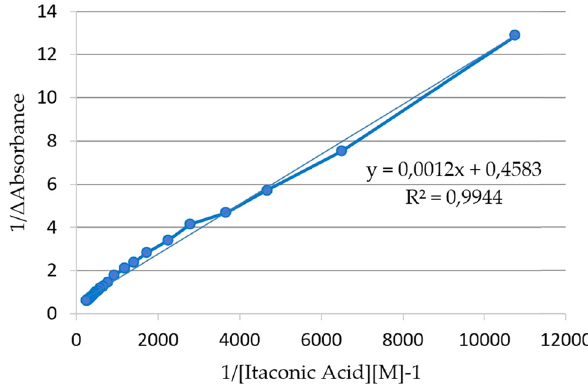
Figure 1: Correlation between 1/ [ Itaconic acid ] [ M ] − 1 and 1/ Δ